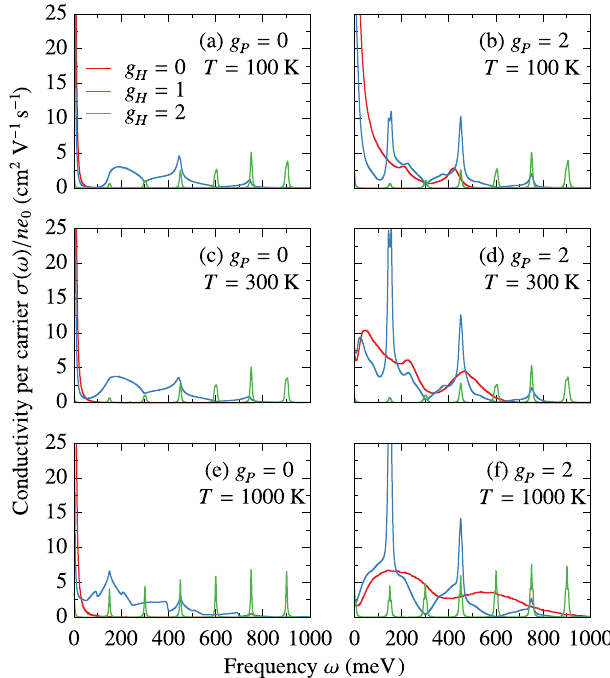
FIG. 2. The per-carrier optical conductivity of the Holstein- Peierls model at different temperatures T ¼ 100 , 300, and 1000 K. Results are shown for the Holstein-only case with 0 [(a), (c), and (e)] and strong dynamic disorder similar to g P ¼ 2 [(b), (d), and (f)]. All other that of high-mobility OMCs g P ¼ parameters are the same as in Fig. 1. Note that in panels (a), (b), (c), and (e), the zero-frequency conductivity is too large to show on the same scale as the other spectral features. See Fig. 3 for details of the zero-frequency